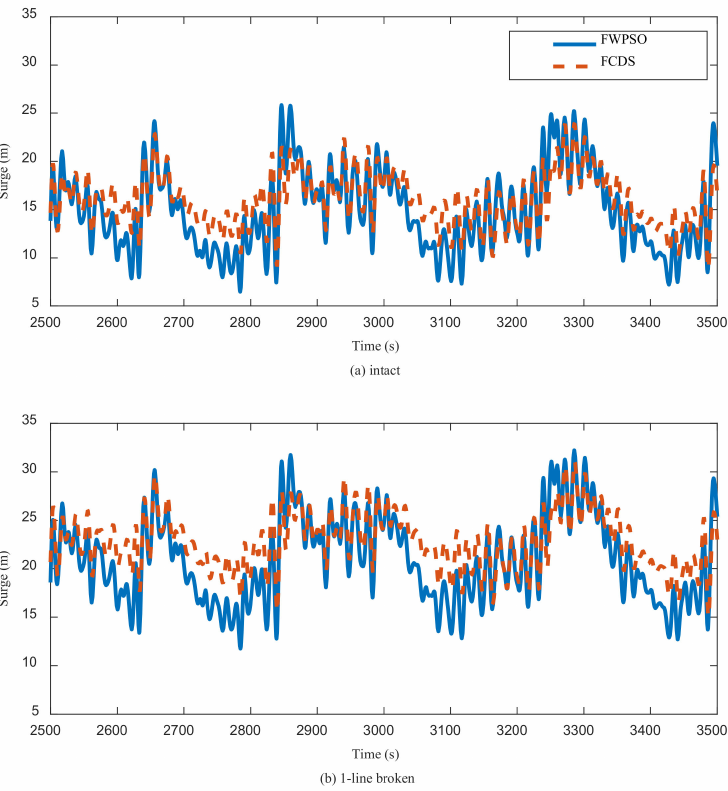
Figure 13. Time histories of the FCDS and FWPSO surge motion under both mooring line statuses.